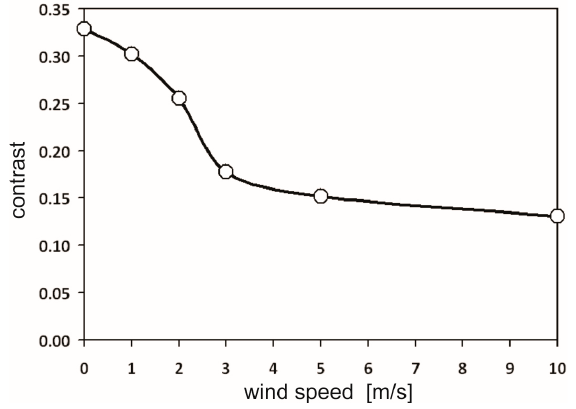
Figure 9. Contrast observed by a detector above the sea surface as a function of wind speed (based on Figure 8).